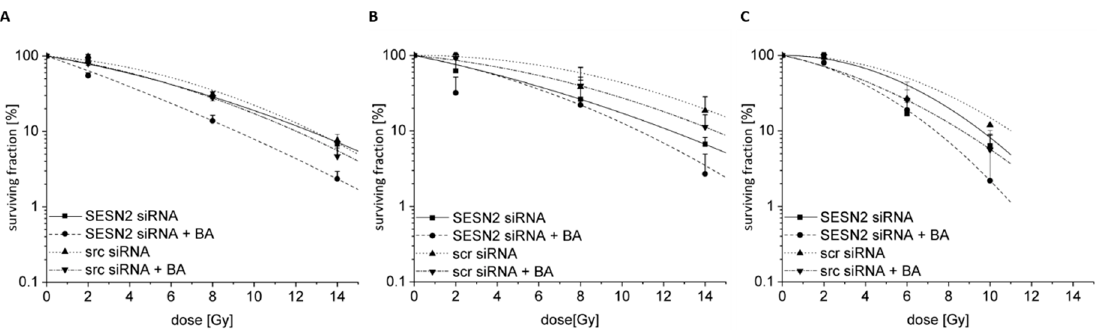
Figure 9. Radiosensitivity of breast cancer cells. Breast cancer cells (( A ) MDA ‐ MB ‐ 231, ( B ) HS578T, ( C ) MCF ‐ 7) were transfected with siRNA against SESN2 and treated with 20 μ M BA under hypoxic conditions (0.1 % O 2 ). 24 h after BA treatment cells were irradiated under hypoxic conditions with different doses depending on cell line. Afterwards, 150 to 10,000 single cells were plated depending on cell line and radiation dose. After approximately 12 days, colonies were stained and counted. Data represent mean values (+SD) of at least three independent experiments.